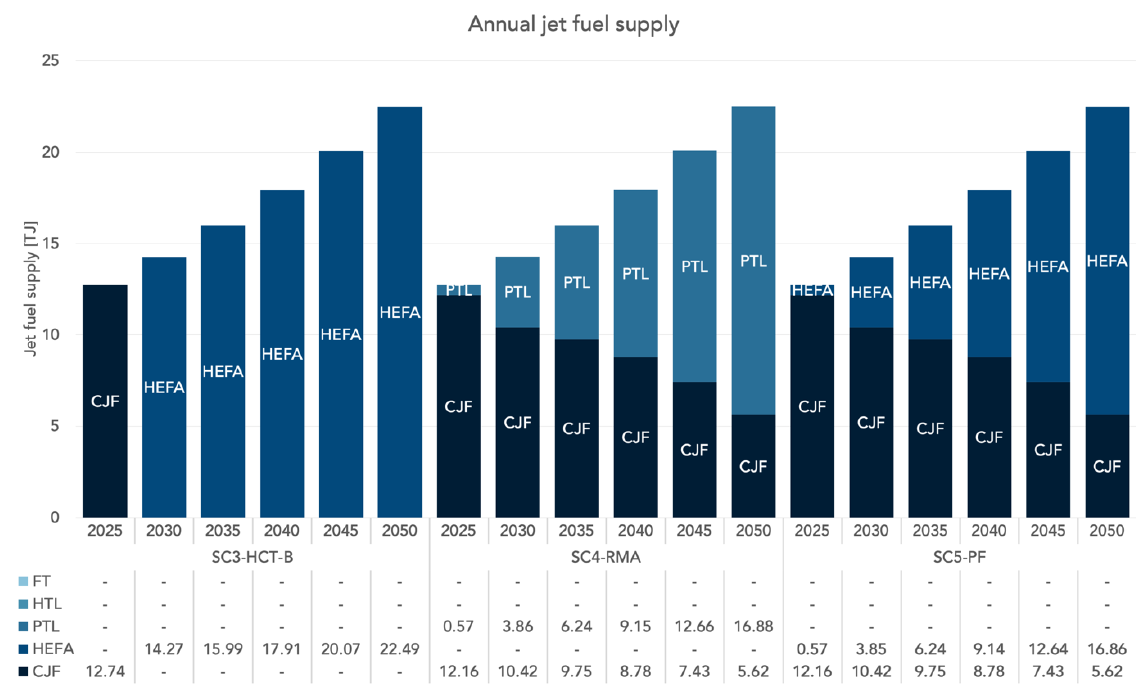
Figure 8. Annual jet fuel supply in scenarios SC3-HCT-B, SC4-RMA and SC5-PF with different policy configurations for 2025–2050. SC3-HCT-B (Higher carbon tax without blending mandate); SC4-RMA (High/Low raw material availability); SC5-PF (With penalty fee); CJF (Conventional jet fuel). FT (Fischer – Tropsch); HTL (Hydrothermal liquefaction); PTL (Power-to-liquid); CJF (Conventional jet fuel); HEFA (Hydroprocessed esters and fatty acids).